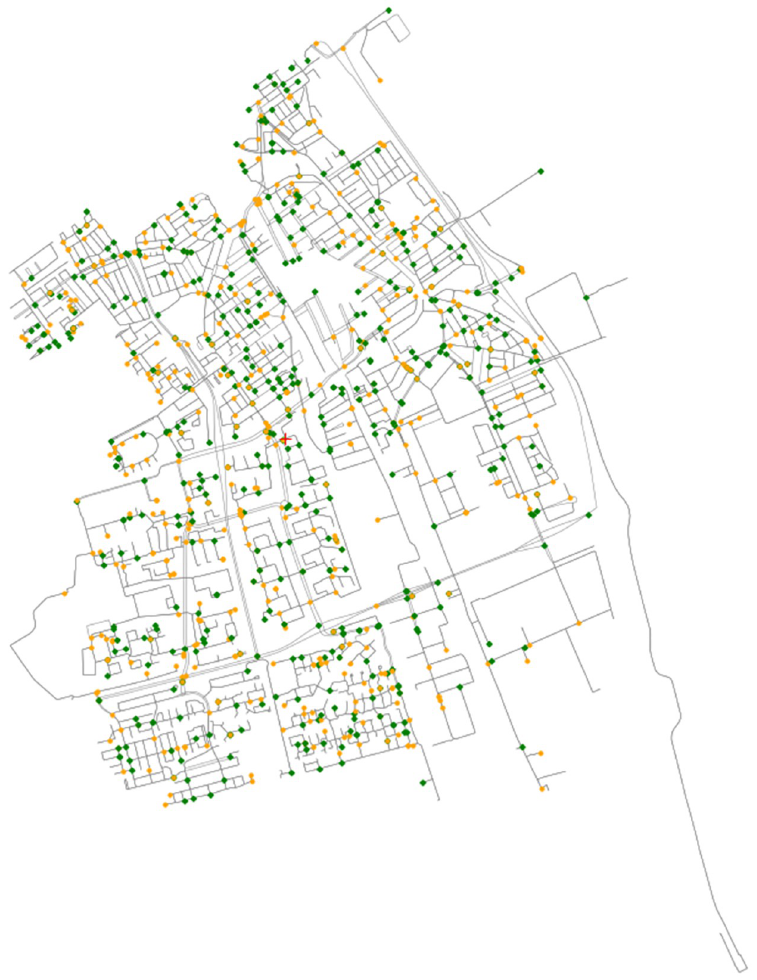
Fig 9. Road network of Delft with origins marked in green, destinations in orange. © OpenStreetMap contributors.